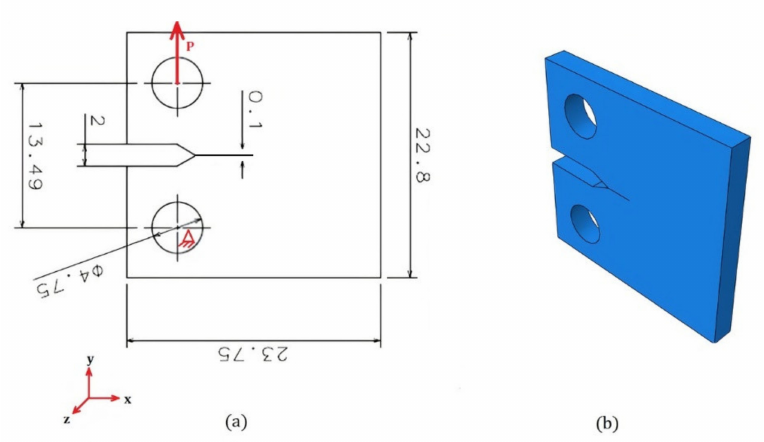
Figure 4. ( a ) Specification of the CT specimen (all units are in mm) ( b ) 3d model of CT